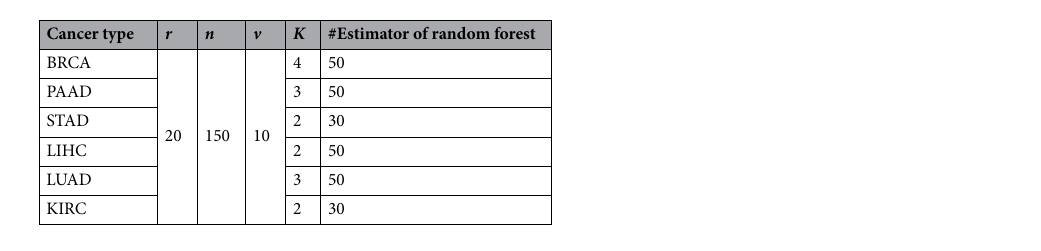
Table 2. Optional parameters of each cancer